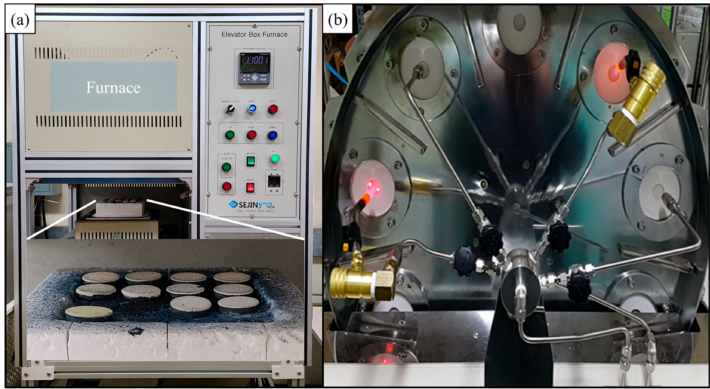
Figure 1. Equipment used in this study: ( a ) FCT equipment; ( b ) JETS test